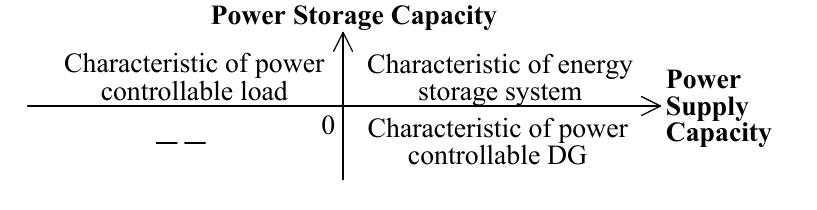
Figure 2. Characteristics of a LACR according to the power supply/storage capacity.